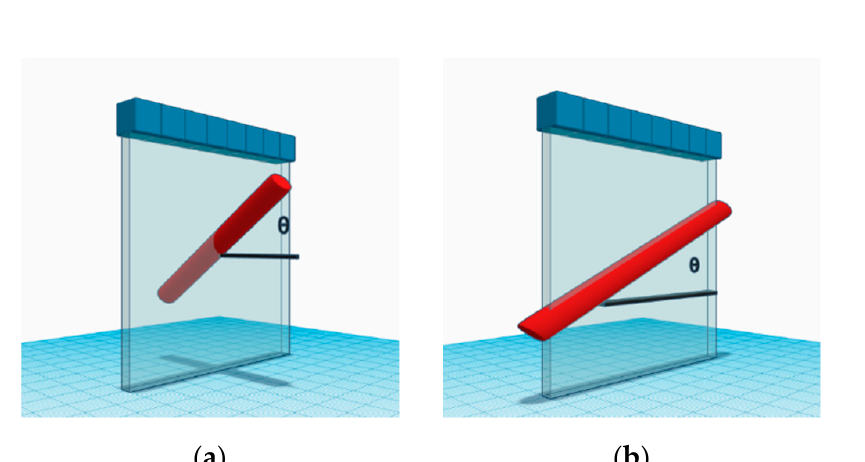
Figure 2. Schematic diagram of the simulated flow vessel in the speckle phantom with an inclined angle of θ for ( a ) cross-view imaging and ( b ) longitudinal-view imaging. Table 1. Imaging parameters in FIELD II simulations.